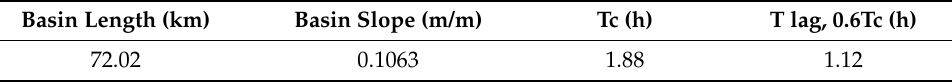
Table 6. Tc and Tlag value of Al-Lusub watershed.